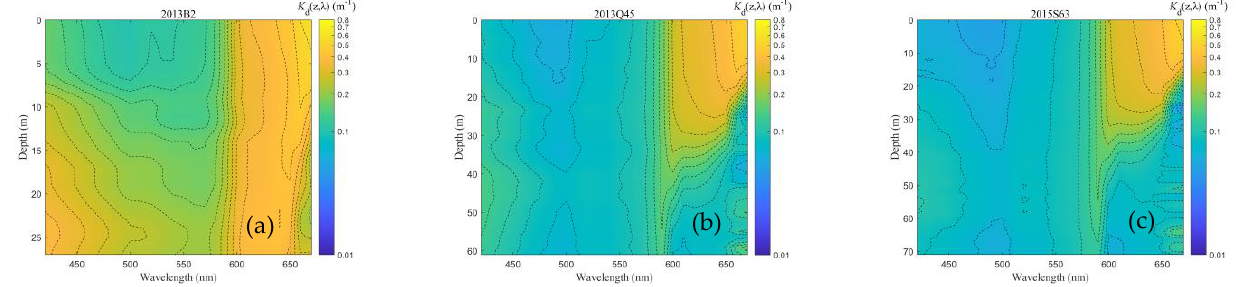
Figure 4. Depth-wavelength distribution characteristics of 𝐾 𝑑 (𝑧, 𝜆) : ( a ) station B2 in 2013 (water column depth: 35 m); ( b ) station Q45 in 2013 (water column depth: 107 m); ( c ) station S63 in 2015 (water column depth: 2716 m).